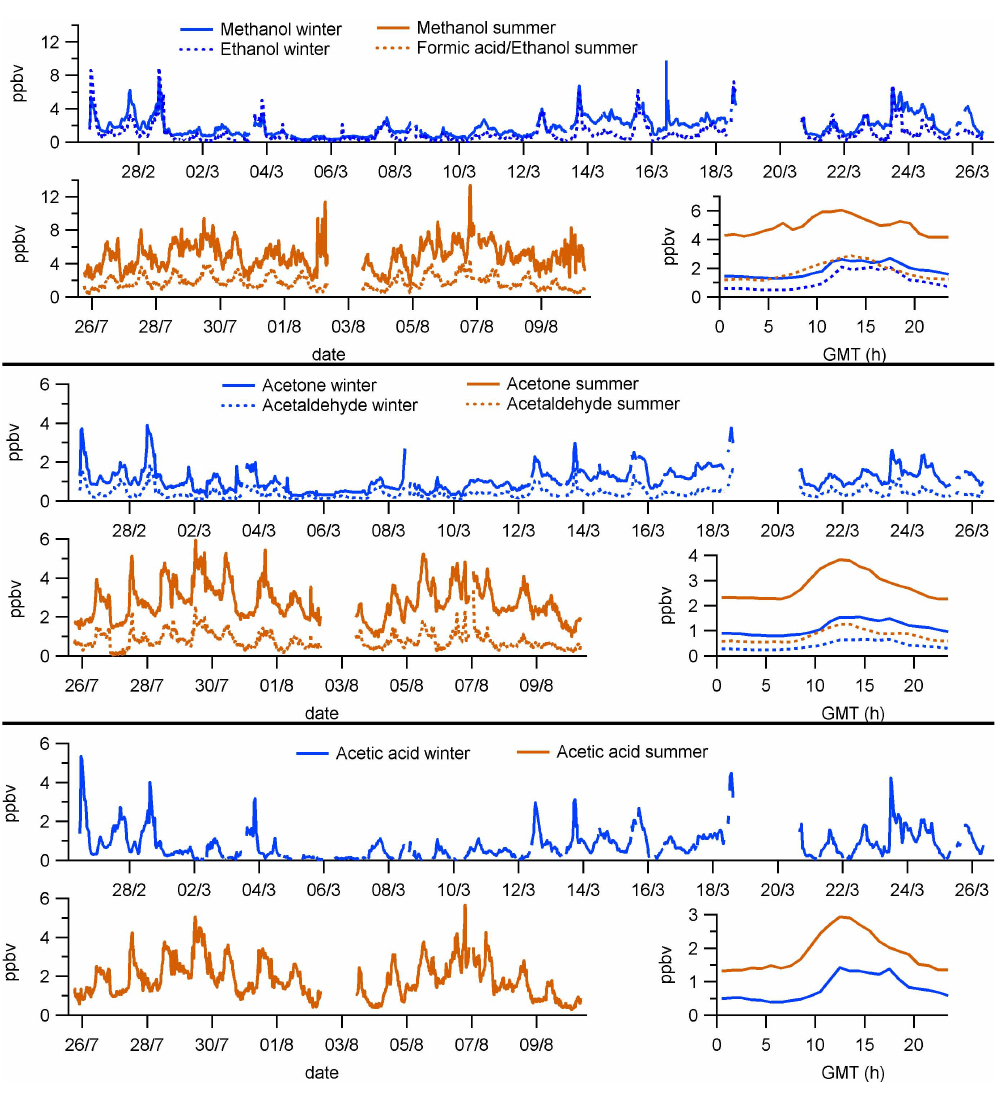
Fig. 5. Short-chain oxygenated VOCs measured at MSY, showing their mixing ratios during the winter period (upper graph of each panel), their mixing ratios during the summer period (lower left graph) and their mean daily cycles (hourly averages) for both periods (lower right graph). Date labels indicate 00:00